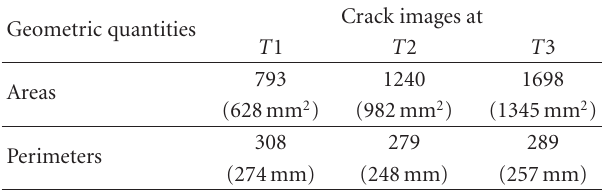
Table 1: Extracted areas and perimeters of cracks (numbers in parentheses are true values of extracted quantities: for areas,